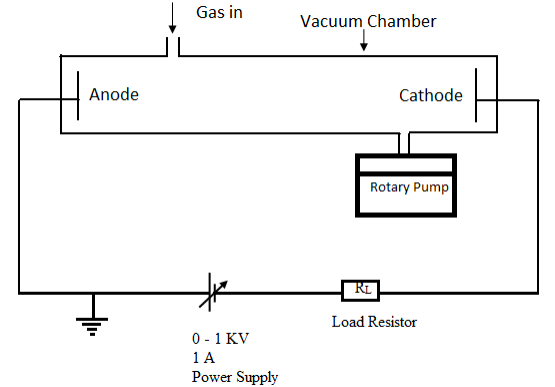
Figure 1: Experimental